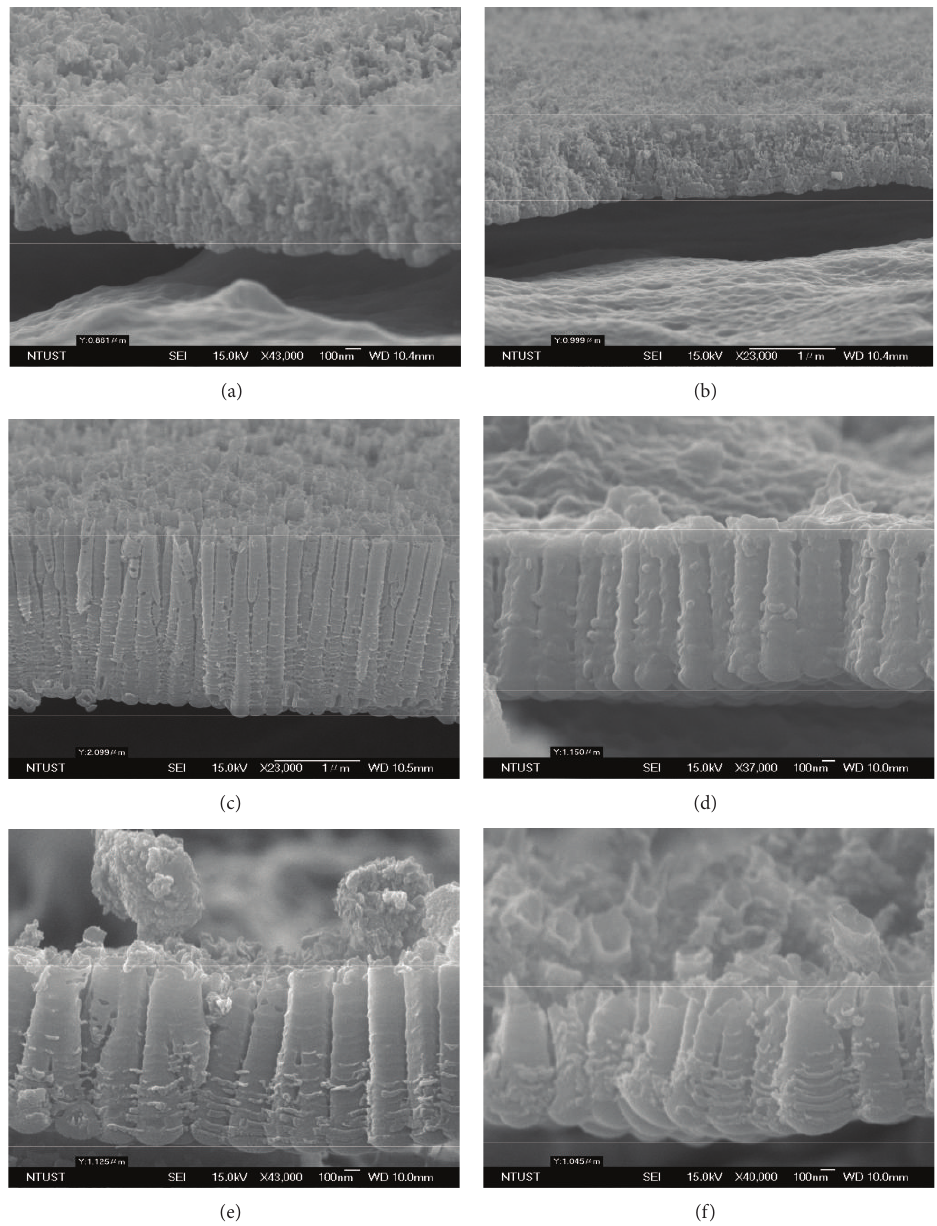
Figure 7: Front view of SEM images of TNT synthesized at different bath temperatures: (a) 10 ∘ C, (b) 20 ∘ C, (c) 40 ∘ C, (d) 50 ∘ C, (e) 60 ∘ C, and (f) 80 ∘